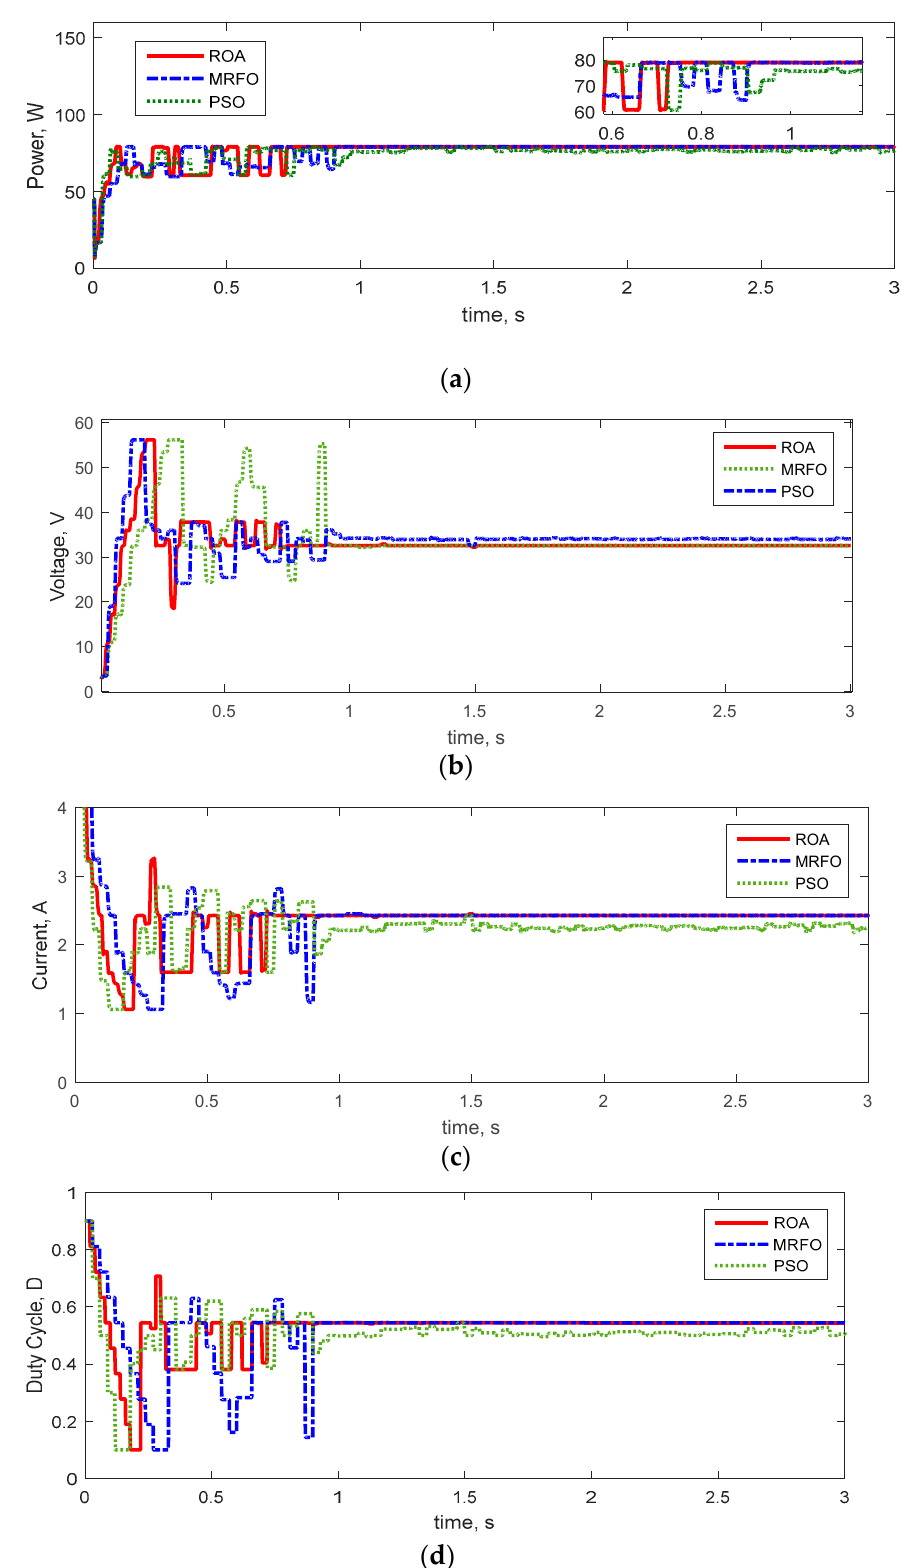
Figure 15. ( a ) PV power, ( b ) PV voltage, ( c ) PV current, ( d ) Duty cycle in pattern 4 using different methods. Table 7. Numerical results of the ROA, MRFO, and PSO methods in pattern 4.